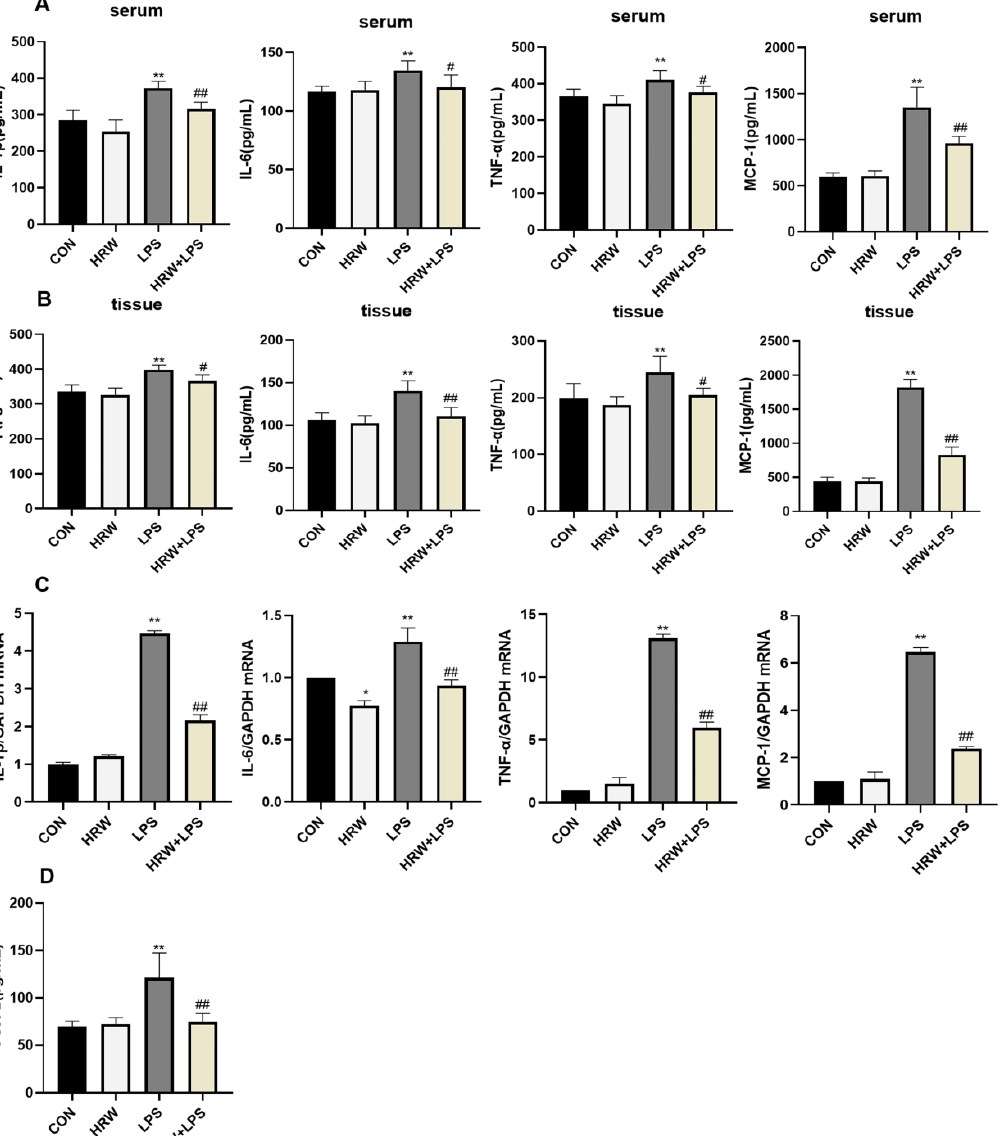
Figure 2. Effects of HRW on inflammatory cytokines in rats with chronic gut inflammation. ( A ) Serum levels of IL-1 β , IL-6, TNF- α , and MCP-1. ( B ) Levels of IL-1 β , IL-6, TNF- α , and MCP-1 in ileal tissue. ( C ) mRNA expression and activity of IL-1 β , IL-6, TNF- α , and MCP-1. ( D ) Level of COX-2 in ileal tissue. *, # p < 0.05; **, ## p <